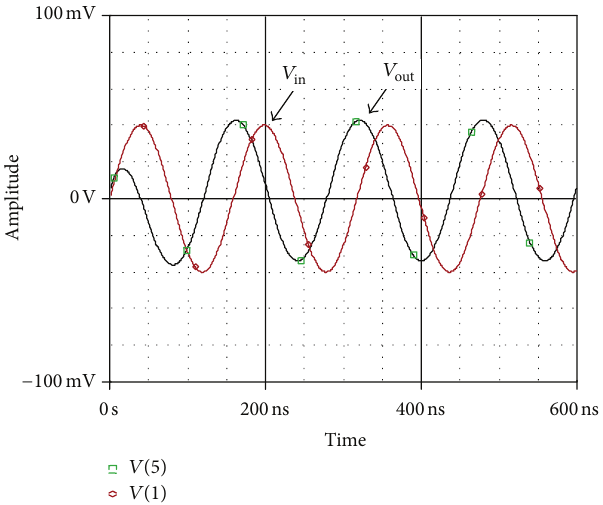
Figure 6: Time domain response of APS at 6 MHz.